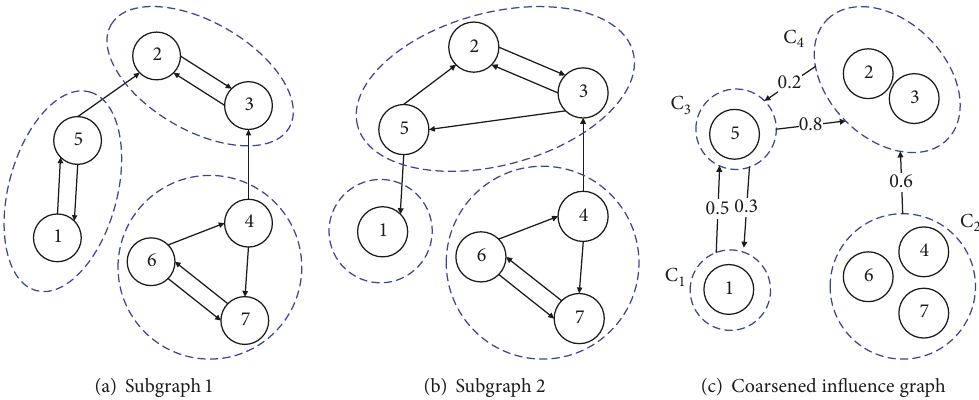
Figure 2: Two subgraphs of 𝑔 and the coarsened influence graph H